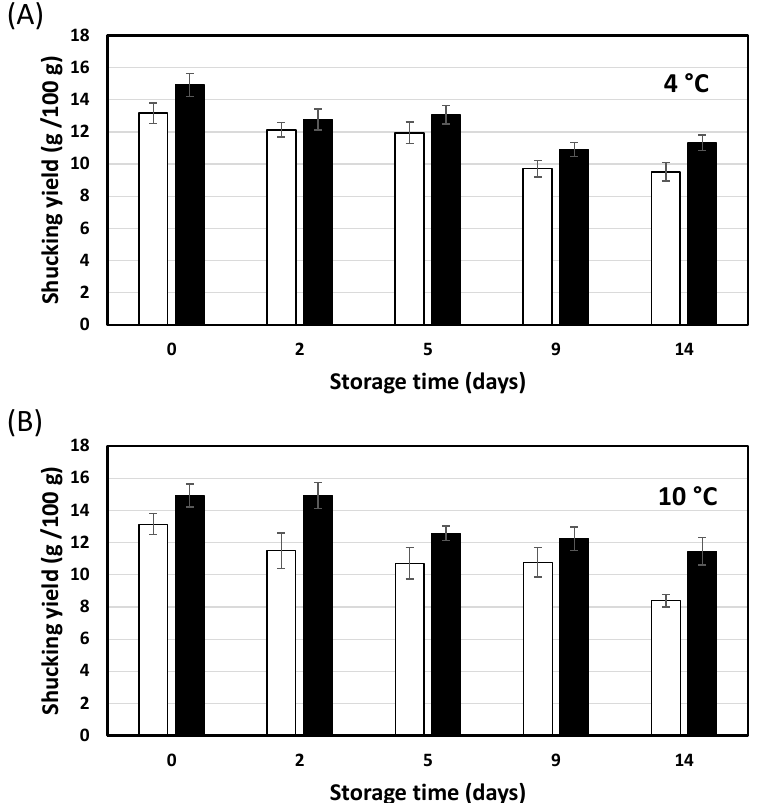
Figure 2. Shucking yield (g/100 g) of both control (white column) and HPP (black column) oysters (300 MPa for 2 min) during the 14 days of storage (sampling points: 0, 2, 5, 9 and 14 days) and at different storage temperatures ( A ) 4 °C and ( B ) 10 °C. All values are means ±95% CI ( n = 20).